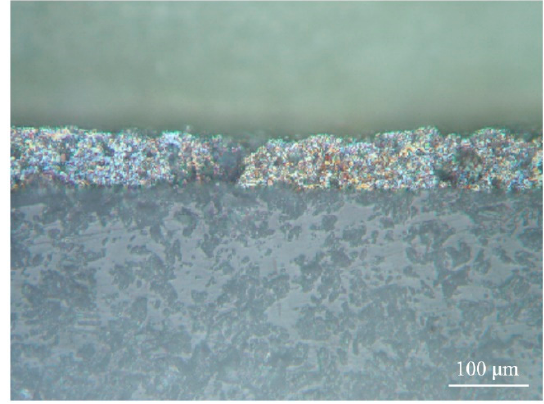
Figure 9. Structure of the coating after adhesion tests.